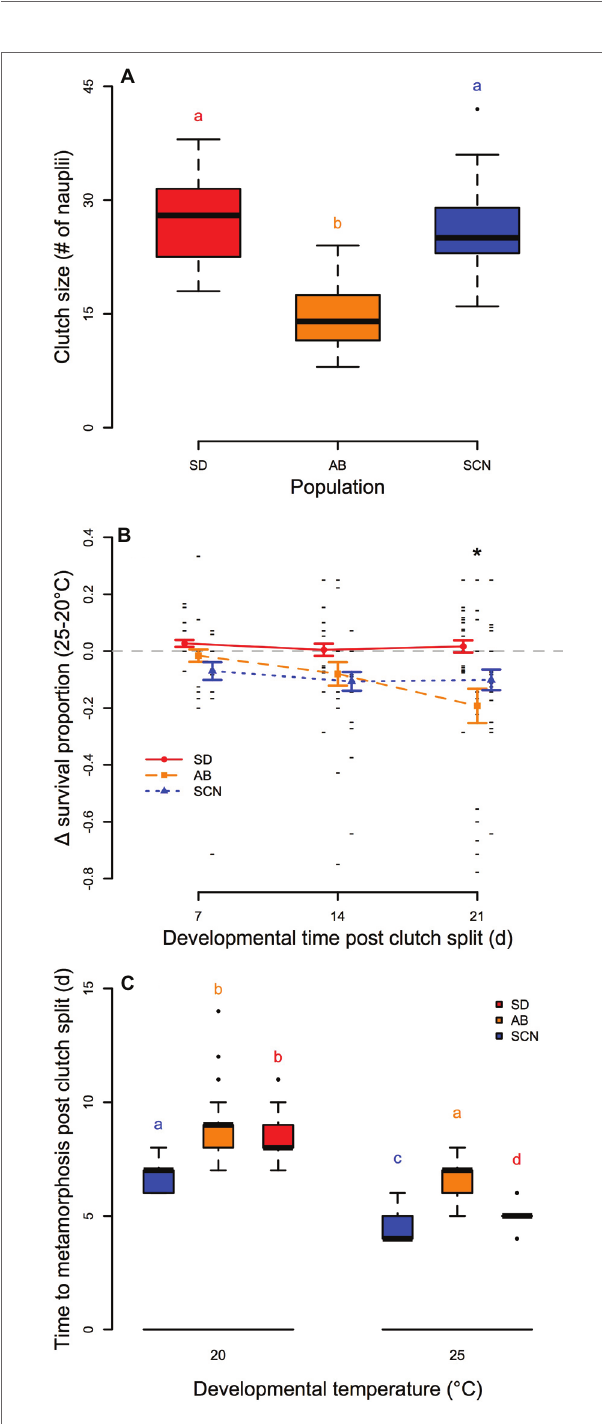
FIGURE 3 | Egg clutch size (A) , survival of development at 25 ° C compared to 20 ° C (B) , and time to metamorphosis at 20 and 25 ° C (C) in San Diego (SD; red, circles, solid lines), Abalone Cove (AB; orange, squares, dashed lines), and Santa Cruz (SCN; blue, triangles, dotted lines) copepods. (A,C) Data are presented as box plots; shared letters indicate groups that are not significantly different. (B) Data are presented as mean ± SEM; small black dashes display difference for individual clutches; asterisk indicates a significantly lower difference in survival between 25 and 20 ° C at 21 days than at 7 or 14 days for AB and a significant difference between SD and AB at 21